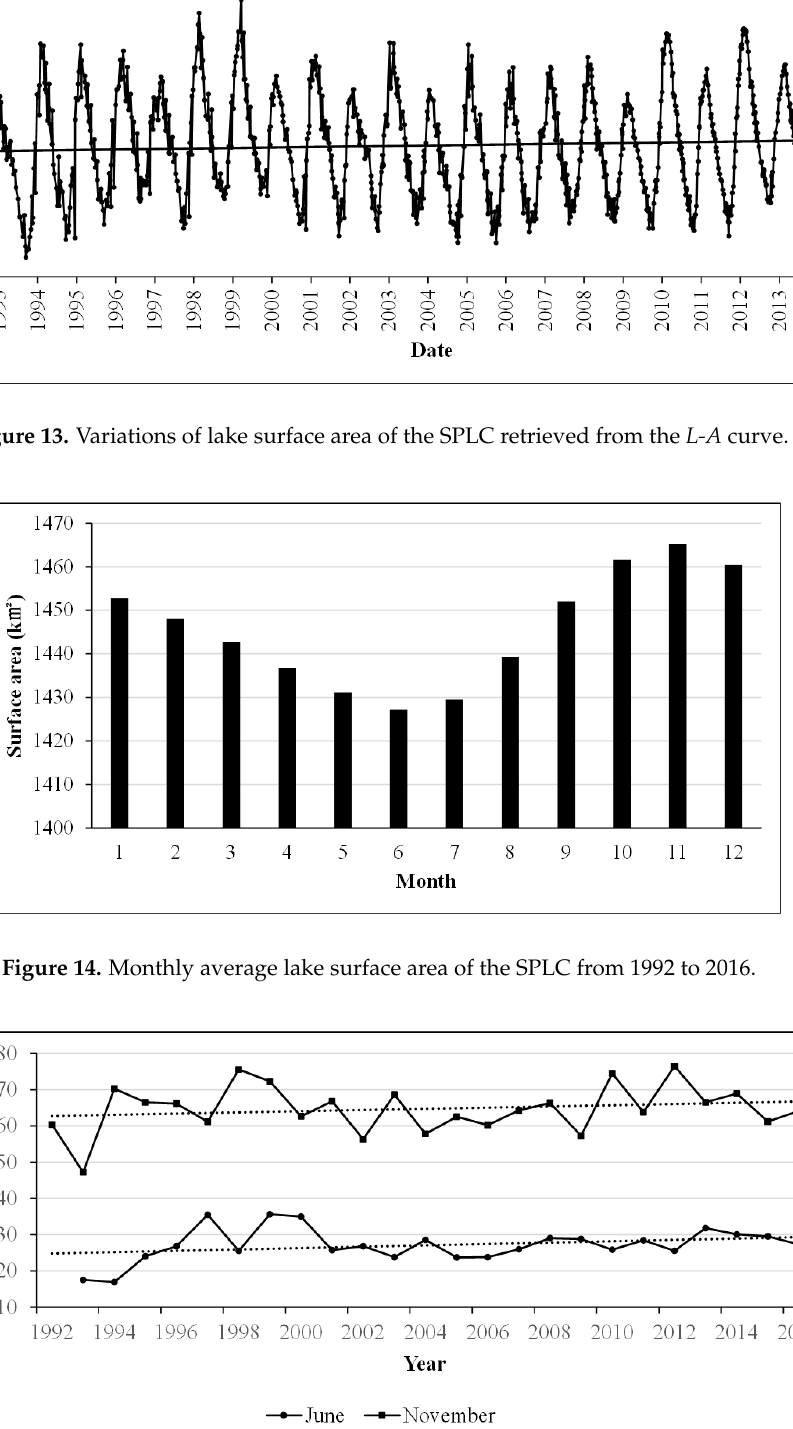
Figure 15. Time series of lake surface area retrieved in June and November.